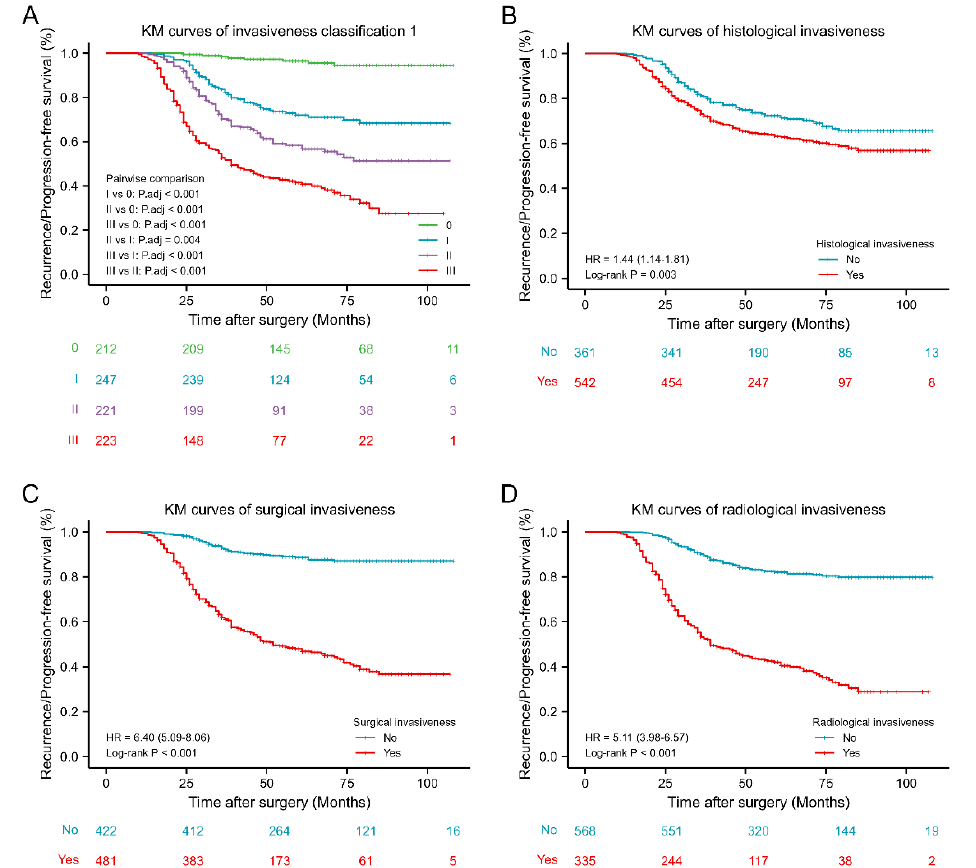
Figure 4. Kaplan–Meier survival curves of different invasiveness groups. ( A ) Kaplan–Meier survival curves of invasiveness classification 1. ( B ) Kaplan–Meier survival curves of histological invasiveness. ( C ) Kaplan–Meier survival curves of surgical invasiveness. ( D ) Kaplan–Meier survival curves of radiological invasiveness. KM: Kaplan–Meier; HR: Hazard Ratio.